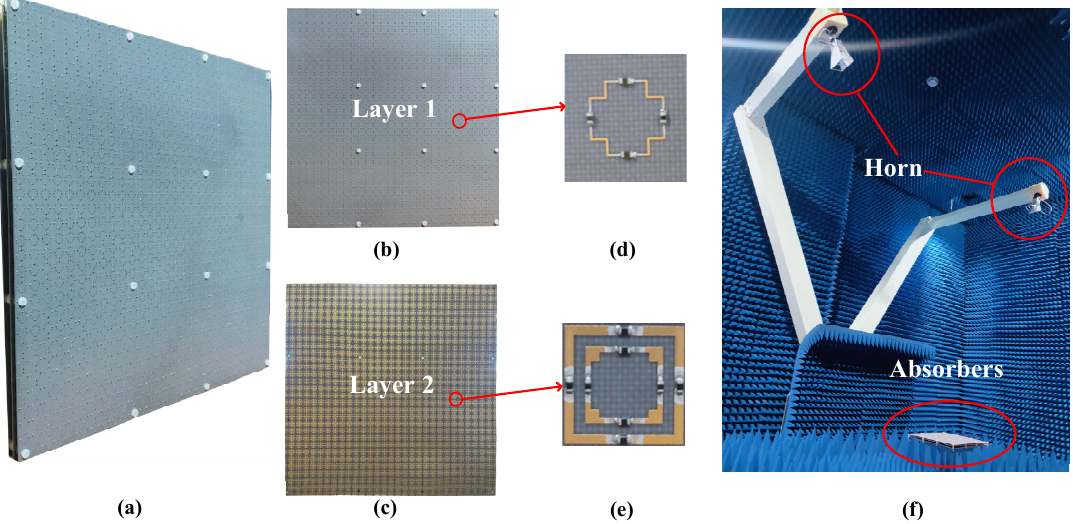
Figure 7. The fabricated prototype and measurement environment. ( a ) the photo of the assembled whole prototype, the front view of ( b ) Layer 1 and ( c ) Layer 2, the detailed unit photo of ( d ) Layer 1 and ( e ) Layer 2, ( f ) the measurement environment configuration.